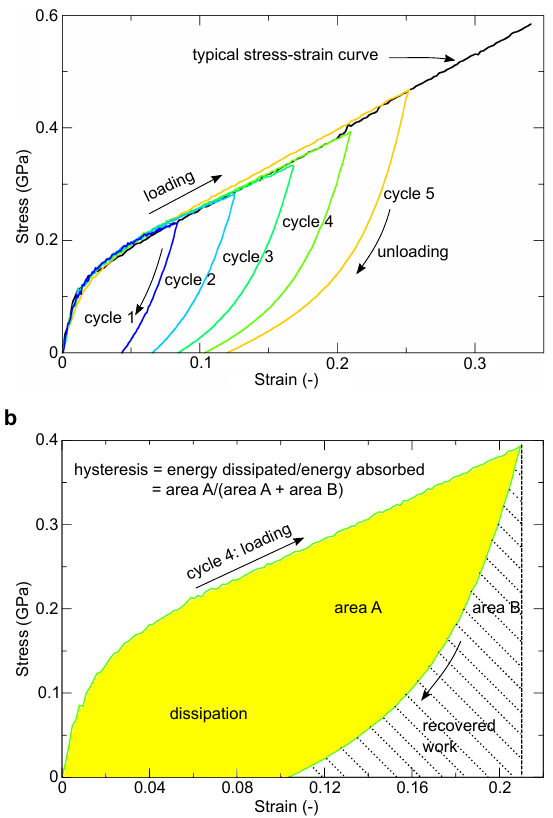
Figure 7. Hysteresis plots for the dragline fiber model of Araneus diadematus . ( a ) Individual loading- unloading cycles (the model was loaded to different levels of strain and unloaded) were performed to obtain hysteresis plots with loading speed of 0.4 m/s. ( b ) Cycle 4: An elongation along the axial direction of the fiber model of 21% of the original length. The energy dissipation in the fiber model is defined as the area between loading and unloading (yellow). Moreover, the area below the unloading curve (shaded area) represents the elastically stored